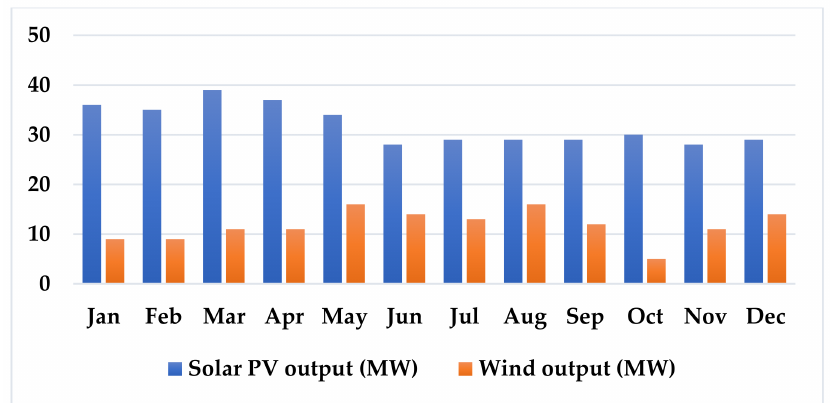
Figure 17. Monthly average solar and wind energy outputs at selected locations.